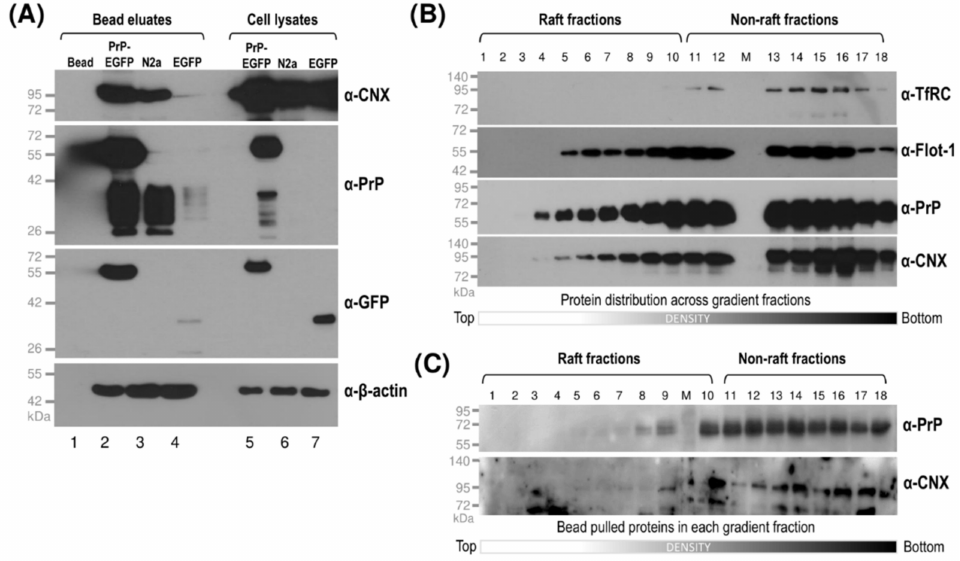
Figure 6. Interaction of the prion protein and calnexin in both raft and non-raft membrane domains indicated by pull-down assay. ( A ) Western blot analysis of the samples after pull-down assay performed on total cell lysates of transgenic PrP-EGFP, EGFP and parental N2a cells. The samples pulled by Ni-NTA beads (Bead eluates) or loaded directly as the input sample (Cell lysates) are probed in parallel for the prion protein (by α -PrP and α -GFP) and for calnexin (by α -CNX). β -actin is used as a loading control and is probed by α - β -actin. Beads, without the sample applied are treated similarly and are used as negative controls (only bead); the molecular weight ladder is indicated on the left side of the blots. ( B ) Separation of raft and non-raft membrane fractions from PrP-EGFP cells to be used for pull-down assay. The fractions are Western blotted for flottilin-1 ( α -Flot-1), transferrin receptor, TfRC ( α -TfRC), for PrP ( α -PrP) and for calnexin, CNX ( α -CNX). The fraction numbers collected from top to bottom of the gradient are indicated on the top, and the raft and non-raft density regions are marked. ( C ) Pull-down assay and Western blot analysis of the individual fractions from ( B ). Fractions are pulled by Ni-NTA beads individually and are probed for the prion protein ( α -PrP) and for calnexin ( α -CNX). M: molecular weight ladder. All gels used are 12% PA SDS